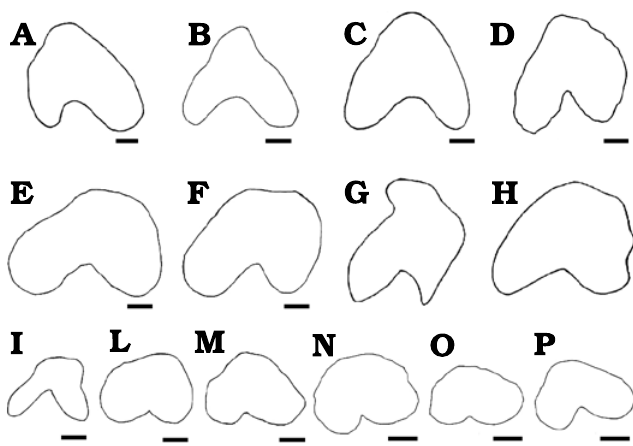
Fig. 6. Upper canine of various hippopotamids in cross section. A . Archa­